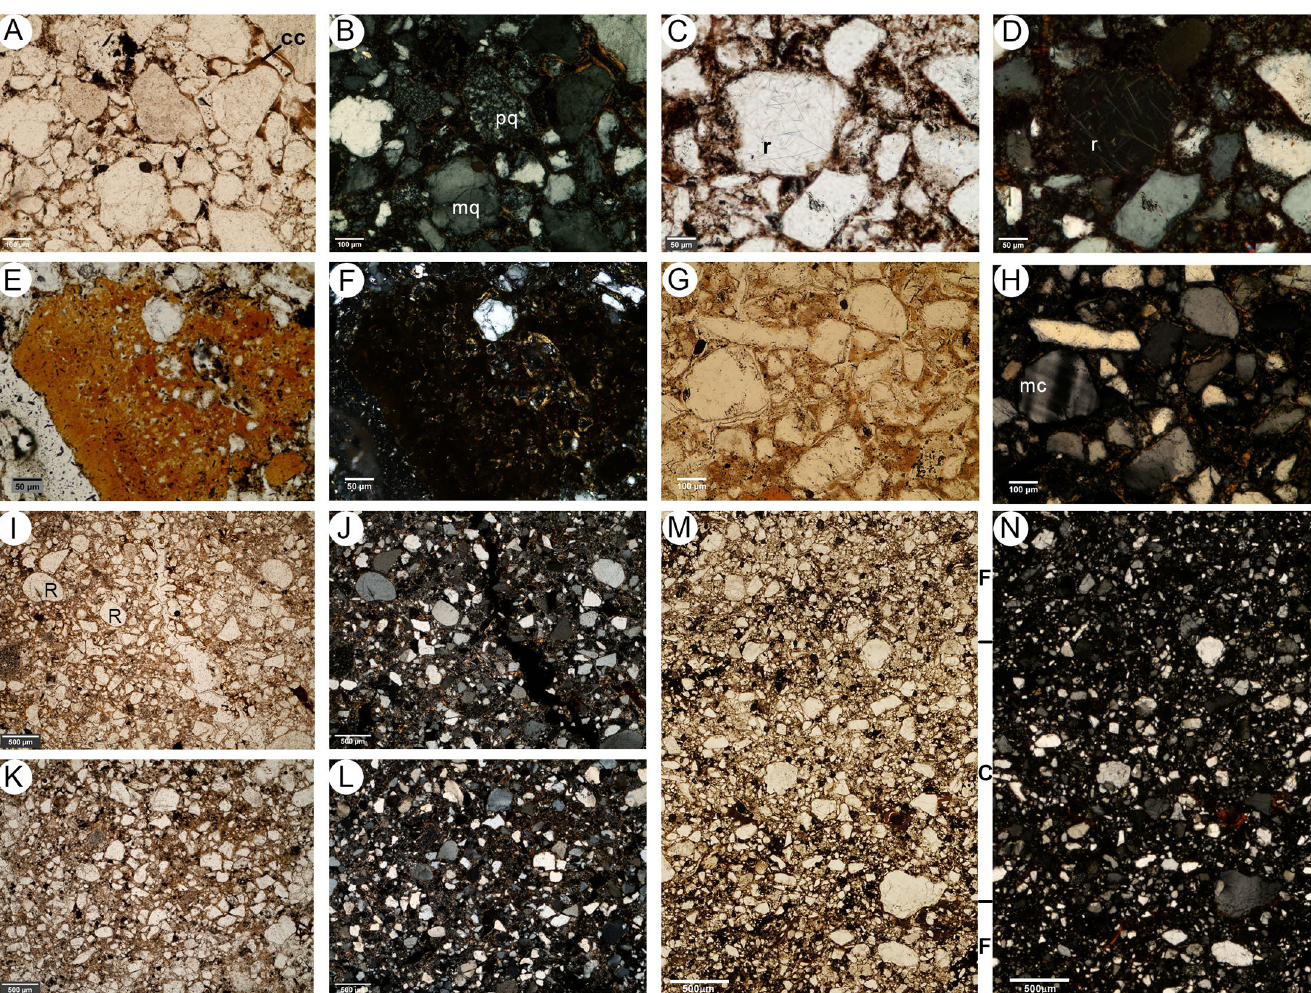
Fig 8. Microphotographs of mineral components and textures of the Amanzi Springs Area 1 sediments sequence. A) subangular to subrounded sand grains, brown illuvial clay coatings (cc) and black amorphous organic matter; parallel polarized light (PPL); DMHS (sample AMZ17/5/1). B) same as in A) under crossed polarized light (XPL), showing monocrystalline (mc) and polycrystalline (pc, probably chert or quartzite) quartz grains; note the medium continuous orientation b- fabric of the clay coatings. C) quartz grain with needle-like rutile inclusions, PPL; DMHS (sample AMZ17/5/1). D) same as in C), XPL. E) very coarse sand-size glassy granule, with perlitic alteration structures, PPL; DMHS (sample AMZ17/5/1). F) same as in E), XPL; note high-birefringence devitrification rims around perlite features. G) relatively abundant reddish-brown clay organised in enaulic and chitonic related distribution pattern among sand grains, PPL; BHS (sample AMZ17/4/3- 4-5, top horizon). H) same as in G), XPL; quartz and microcline (mc) sand grains and low-birefringence stipple-speckled b-fabric of clay. I) relatively common rounded (R) sand grains, PPL; LMHS (sample AMZ17/2/3-4, lower part). J) same as in I), XPL. K) sand texture dominated by angular particles; fine fraction more abundant than in I); BHS (sample AMZ17/2/3-4, upper part). L) same as in K), XPL. M) crude layering of fine (F) and coarse (C) horizons, the fine ones including more amorphous organic matter, PPL; DMHS (sample AMZ17/5/1). N) as in M,